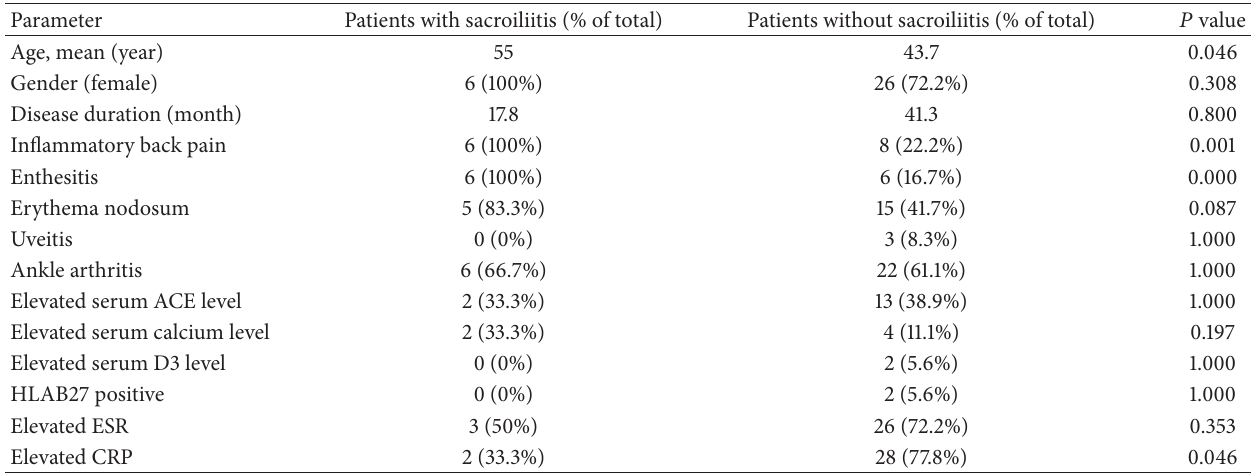
Table 1: Clinical, laboratory, and demographic characteristics of sarcoidosis patients with ( 𝑁 = 6 ) and without ( 𝑁 = 36 ) sacroiliitis.